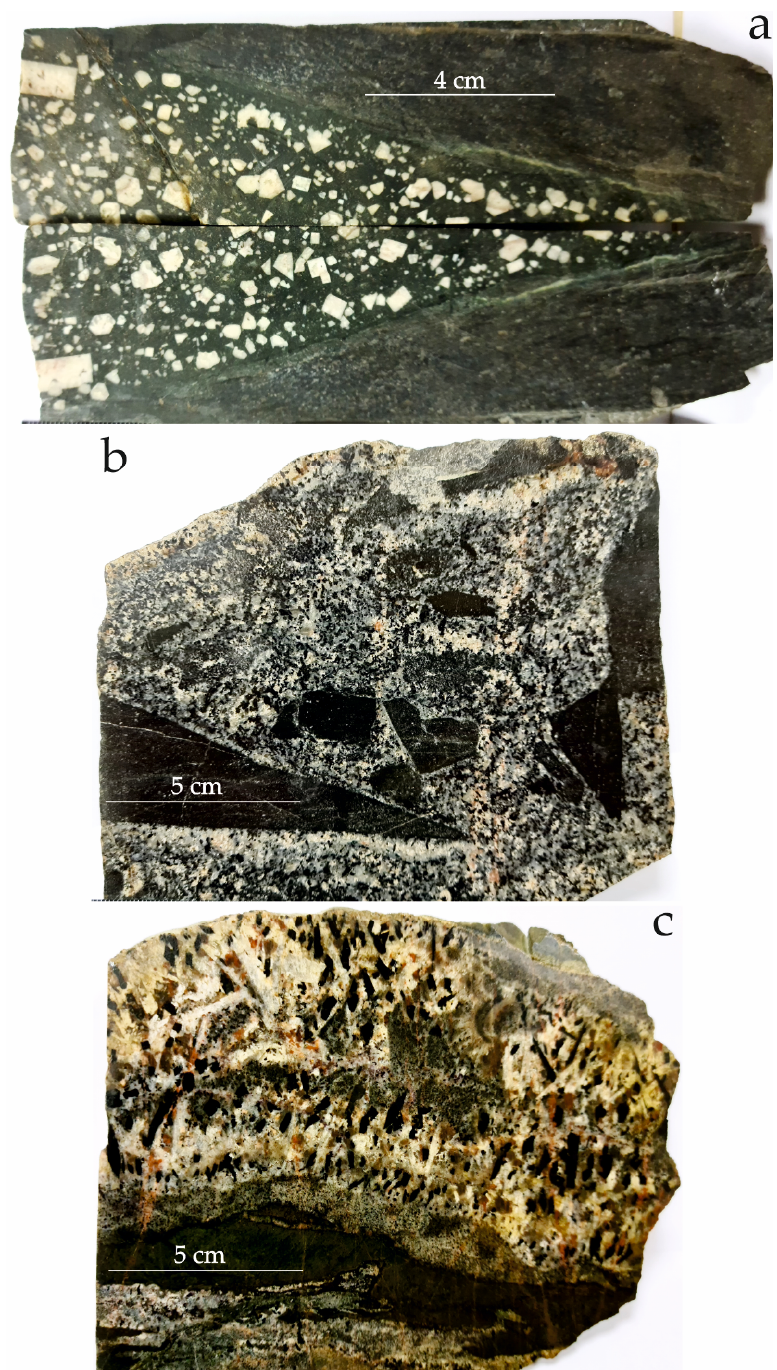
Figure 6. Hand sample photographs of some small dikes N-trending belonging to the University pluton: ( a ) an urtite-porphyry dike intersecting the volcanogenic deposits of the Berikul Formation in the core of the drill hole (sample С-46); ( b ) subalkaline gabbro with xenoliths of brecciated basalt fragments (sample UN-2/1) and ( c ) veinlet’s of pegmatoid nepheline syenite in feldspar micro-ijolite, which cut the ijolite plagioclase (sample 15B). ◦ (cid:48) (cid:48)(cid:48) ◦ (cid:48) (cid:48)(cid:48) In some dikes, nepheline syenites (N55 04 45 , E88 23 14 ) and microsyenites are noted, which cut thin veins of ijolite plagioclase (Figure